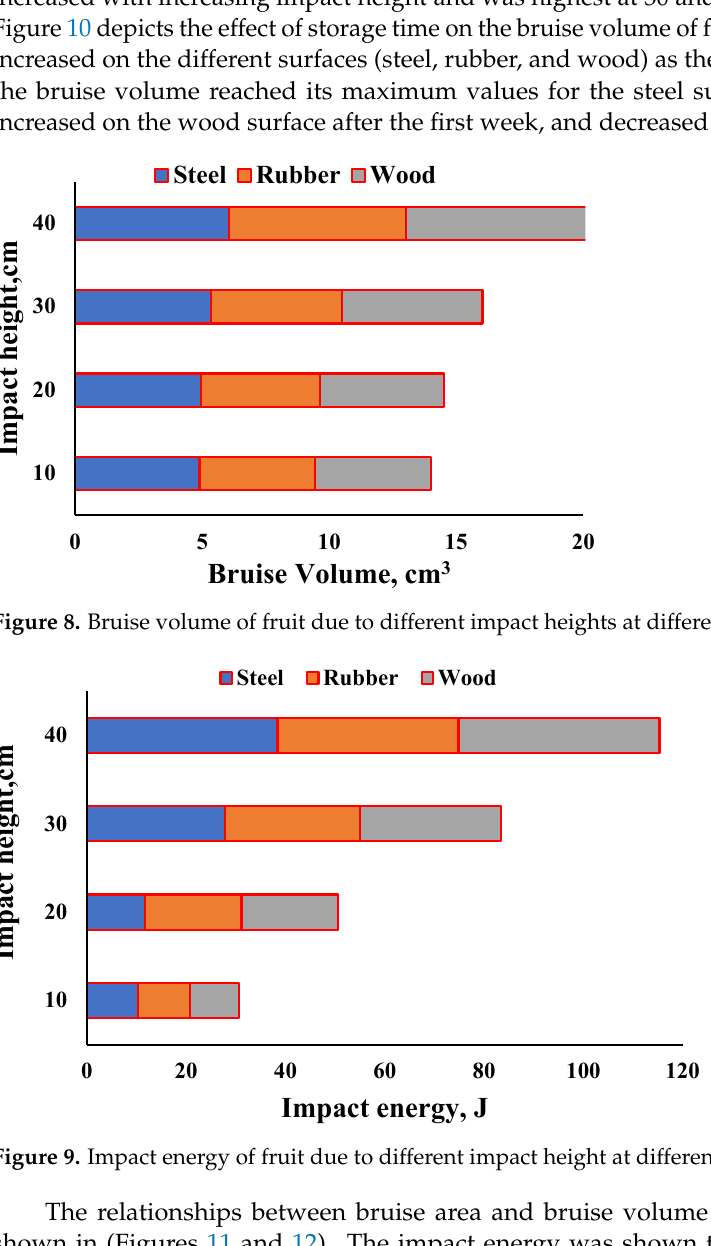
Figure 10. Bruise volume vs. storage time at different surface for cantaloupe fruit.